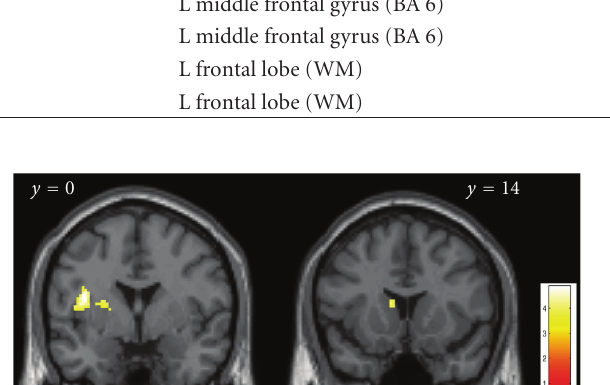
Figure 5: Visualization of brain regions related to exposure e ff ect. Surface rendering of the statistical activation map of the exposure e ff ect in listening to melodies (areas showing increased activity with increased previous exposure). Random e ff ects analysis; P < 0 . 001, uncorrected, only clusters of more than 10 voxels included. IFG: inferior frontal gyrus; IPL: inferior parietal lobe; MidFG: middle frontal gyrus; Postcentr. G: postcentral gyrus; SMG: supramarginal gyrus. Leftmost rendering is of the left hemisphere.